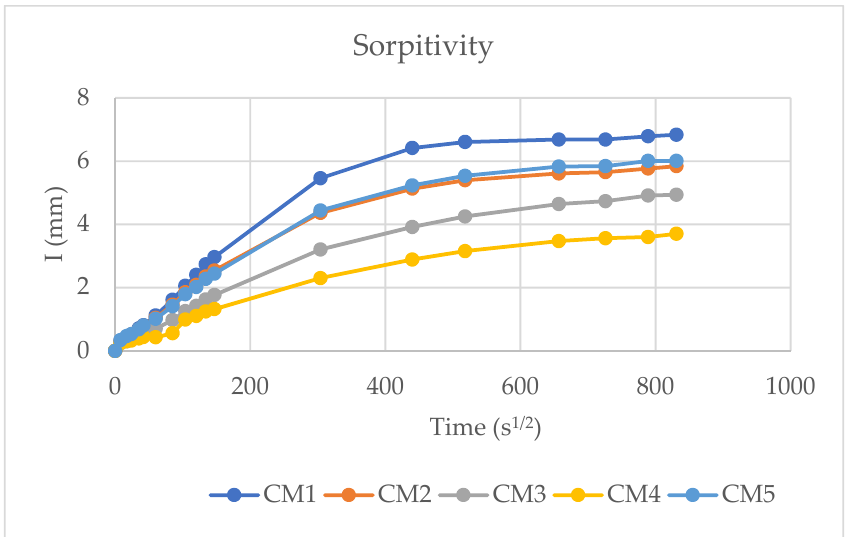
Figure 11. Water Sorptivity of CM-UFS-GO composites.